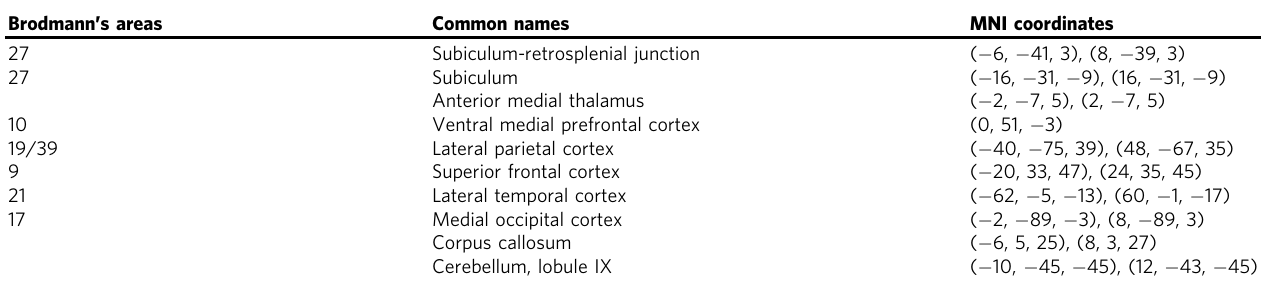
Table 1 Locations of local maxima within our lesion-derived episodic memory network Brodmann ’ s